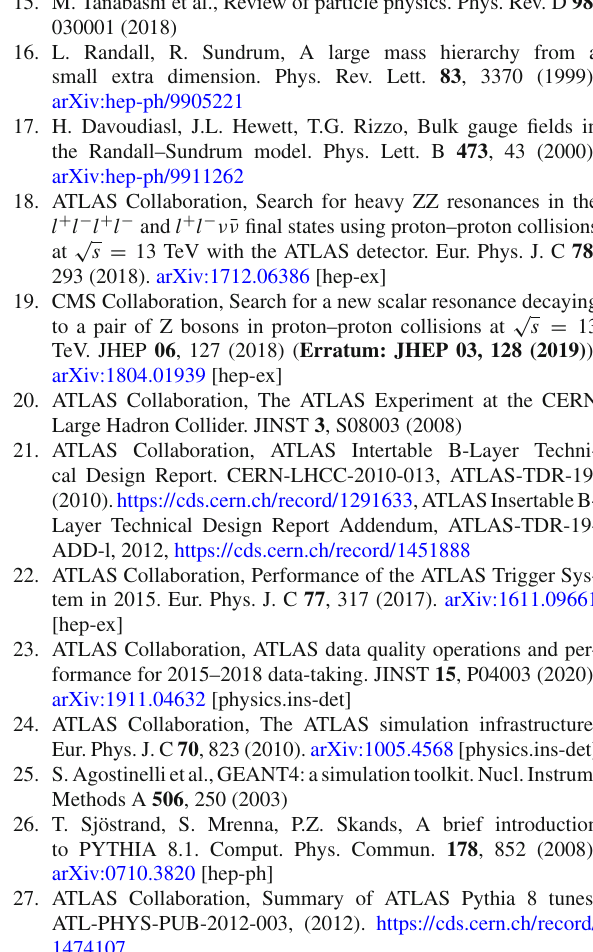
Fig. 10 The upper limits at 95% CL on the cross section times branch- ing ratio as a function of the heavy resonance mass m H for a the ggF production mode ( σ ggF × B ( H → Z Z ) ) and b for the VBF produc- tion mode ( σ VBF × B ( H → Z Z ) ) in the case of the NWA. For the